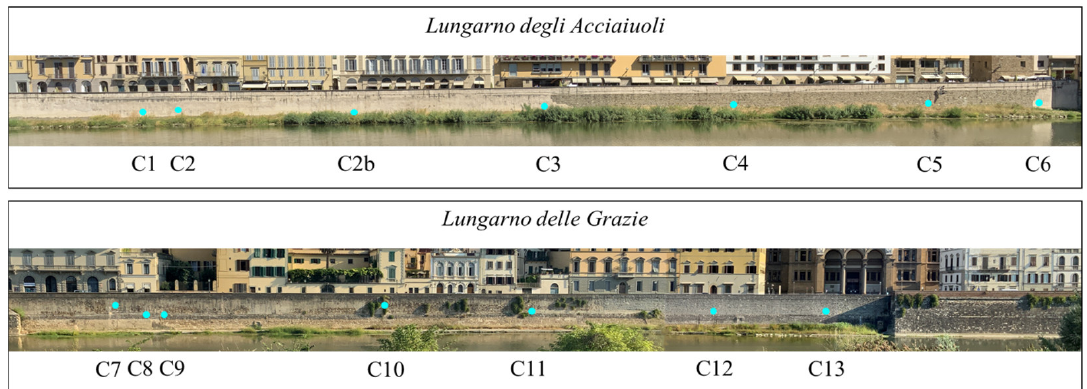
Figure 2. Position of core sampling: 14 masonry cores (light-blue dots) were extracted (7 core samples from Lungarno degli Acciaiuoli and 7 from Lungarno delle Grazie ). A macroscopic description was performed on site using an endoscopic and optometric survey to identify macroscopic features of the masonry and in the laboratory using a Zeiss optical stereomicroscope up to 200 magnifications. The combination of the techniques allowed identification of 4 typologies of mortar, which are named X, Y, W, and Z. In Figure 3, the macroscopic aspect of these types are reported: historic mortar with decimeter-sized coarse aggregates (type X), historic mortar with centimeter-sized coarse aggregates (type Y), modern mortar with millimeter-sized coarse aggregates (type Z), and modern mortar with centimeter-sized coarse aggregates (type W). The term historic mortar is used to indicate a mixture of a traditional binder, fine aggregates, water, and possible additives used in riverbanks as filling of the nucleus of the masonry, while the term modern mortar is used to identify modern hydraulic binder and fine aggregates mixed with water and additives. The coarse aggregates are largely composed of stone fragments, such as Pietraforte , Pietra Serena , and Pietra Alberese. Pietraforte and Pietra Serena are the most used sandstones in Florentine architecture [33,34], while Pietra Alberese is a marly limestone that in Florence was mainly used for lime production [35].